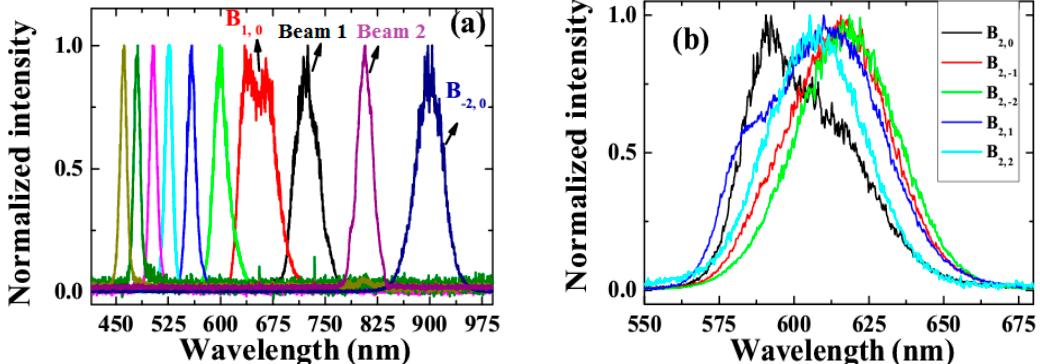
Figure 17. The spectra of sidebands on ( a ) the center row B m,0 ; and ( b ) the second column B 2,n